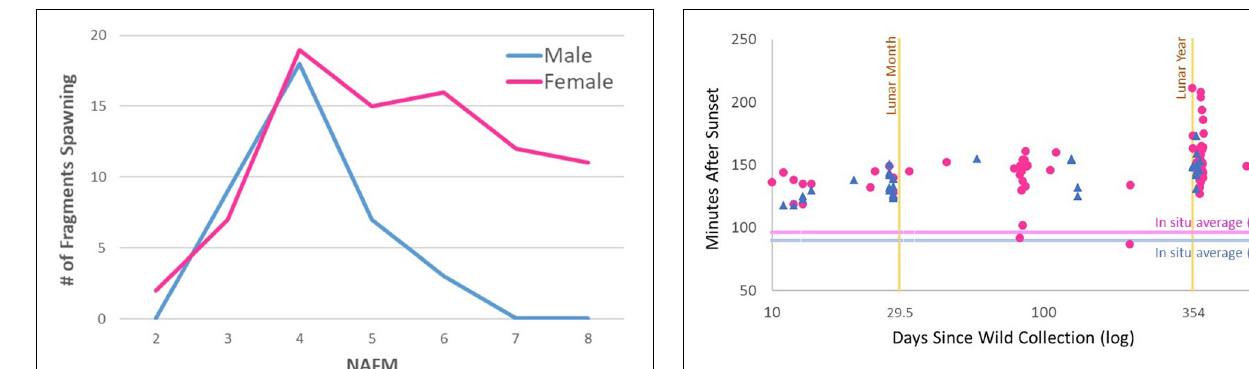
FIGURE 3 | Number of ex situ Dendrogyra cylindrus fragments spawning on each night after the full moon (NAFM). Numbers are summed across two facilities and all years of observation. Male spawning peaked on NAFM 4 and decreased to zero by NAFM 7. Female spawning continued through NAFM 8.